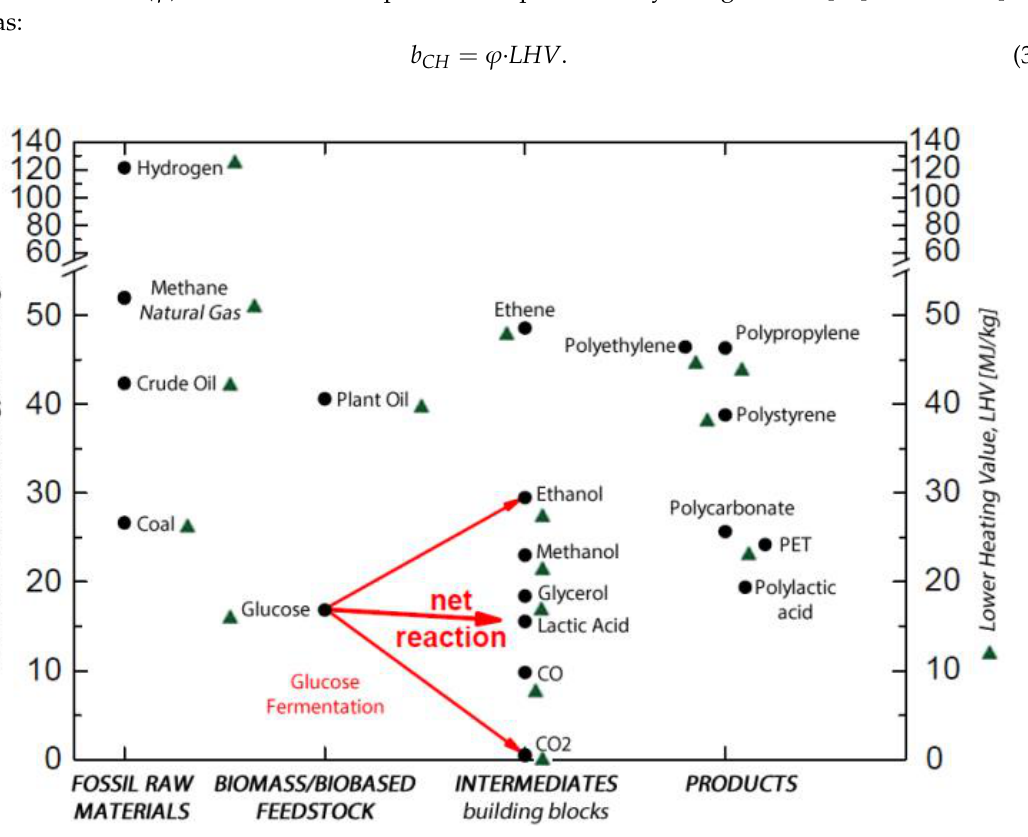
Figure 3. Standard chemical exergy and lower heating value for selected resources. Adapted from Frenzel and Pfennig [35].